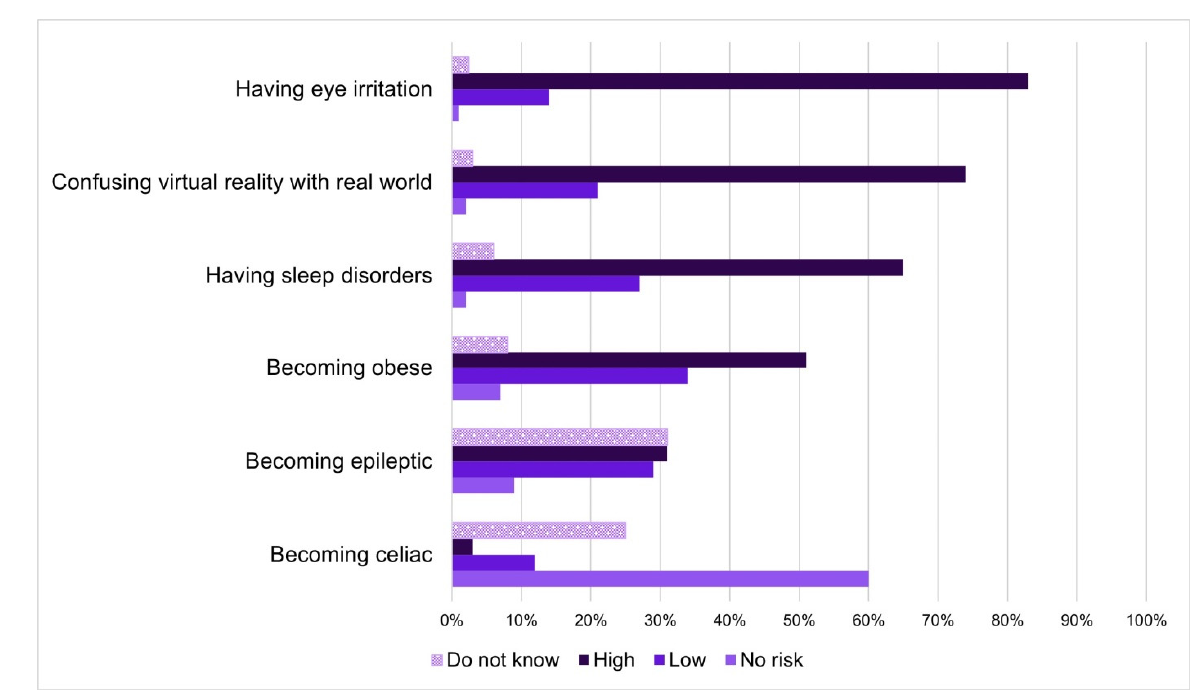
Figure 1. Evaluation on the risk of developing certain situations/symptoms regarding the use of MDs by children under the age of 5, using a 7-point Likert scale. No risk = score 1, Low = scores 2, 3, 4, High = scores 5, 6, 7.